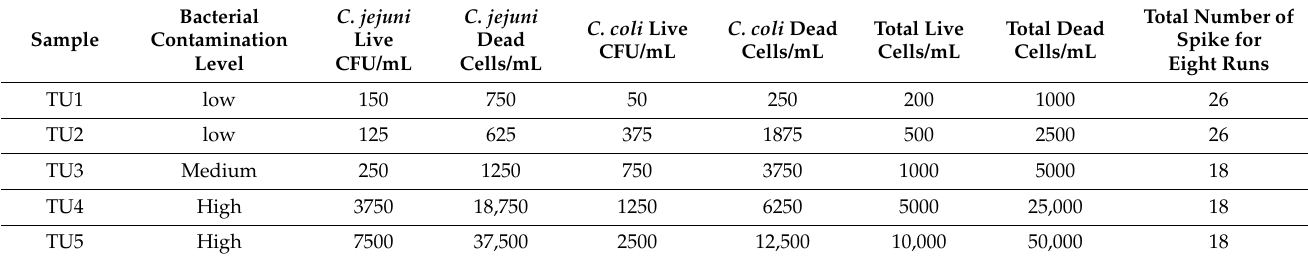
Table 5. Spiking plan for the technical measurement uncertainty study. For each sample, chicken neck skins (low organic matter content of meat rinse, 12 mg) were artificially contaminated with live and dead cell